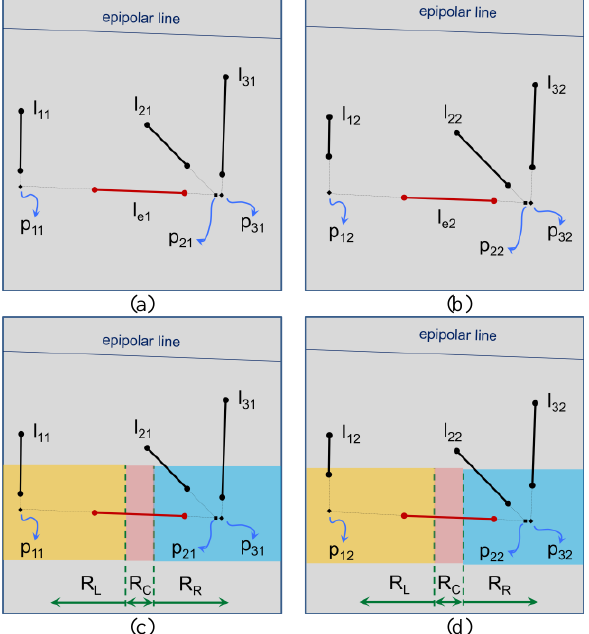
Fig. 6 Left (a-c) and right (b-d) stereo images. The directional regions utilized during the selection of the best weighted point entities.